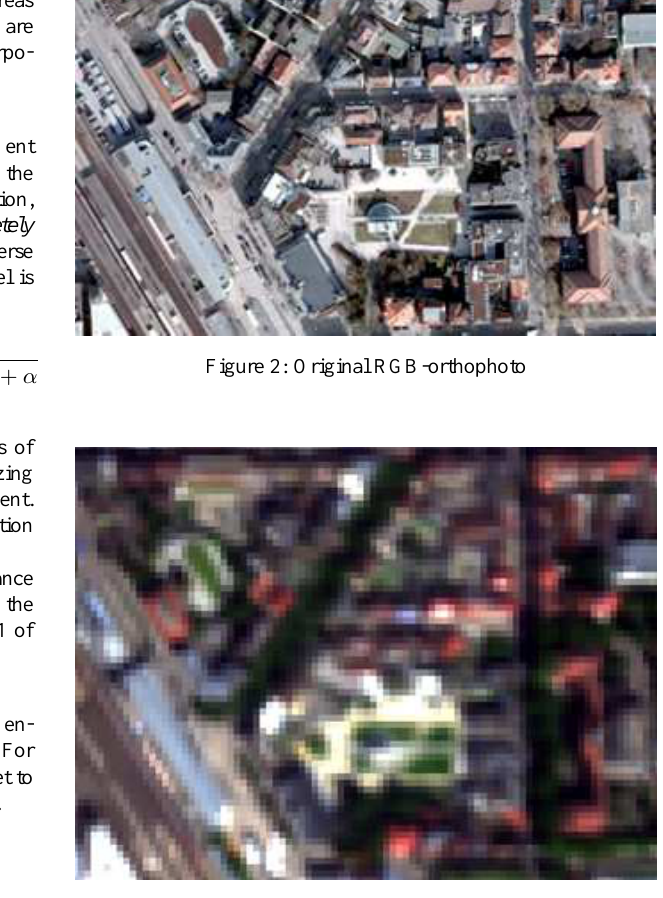
Figure 3: RGB channels of the original hyperspectral